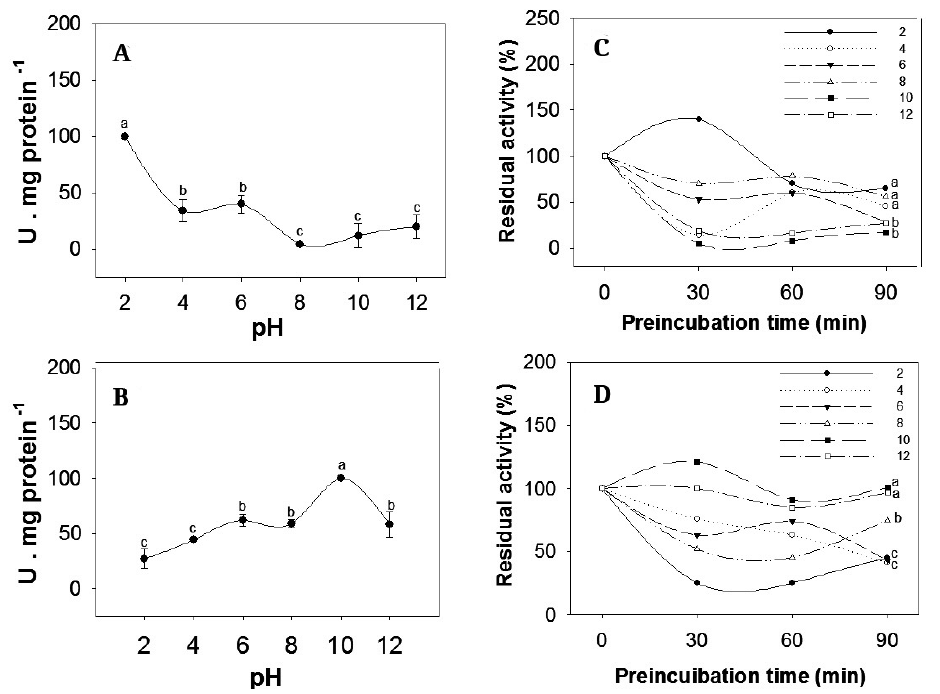
FIGURE 1 | Effect of pH on the enzymatic activity of digestive proteases of short-tailed pipefish ( Microphis brachyurus ) juveniles for the determination of: A. optimal pH of acidic proteases; B. optimal pH of alkaline proteases; C. pH stability of acidic proteases; and D. pH stability of alkaline proteases (mean ± SD, n = 3). Mean values denoted with different letters are statistically different, p <